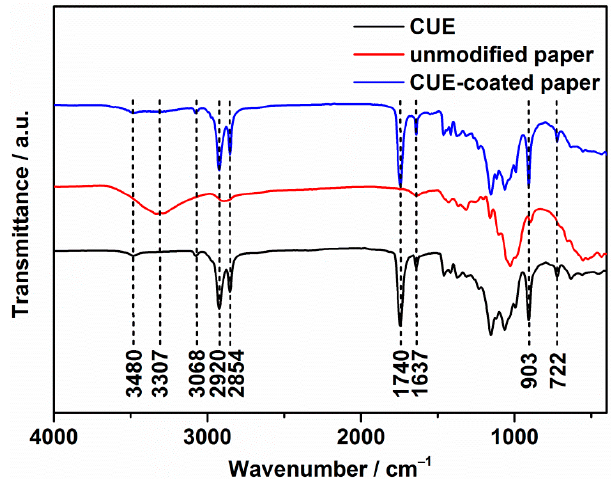
Figure 2. FTIR spectra of CUE, unmodified paper, and CUE-coated paper (CUE 11.62 -coated paper).